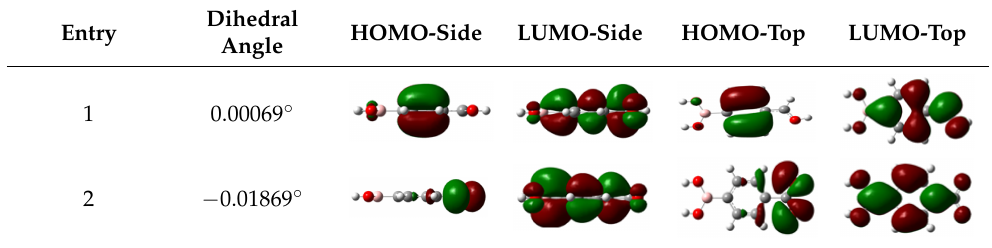
Table 3. Electron density diagram of HOMO/LUMO states in PAS and CS.